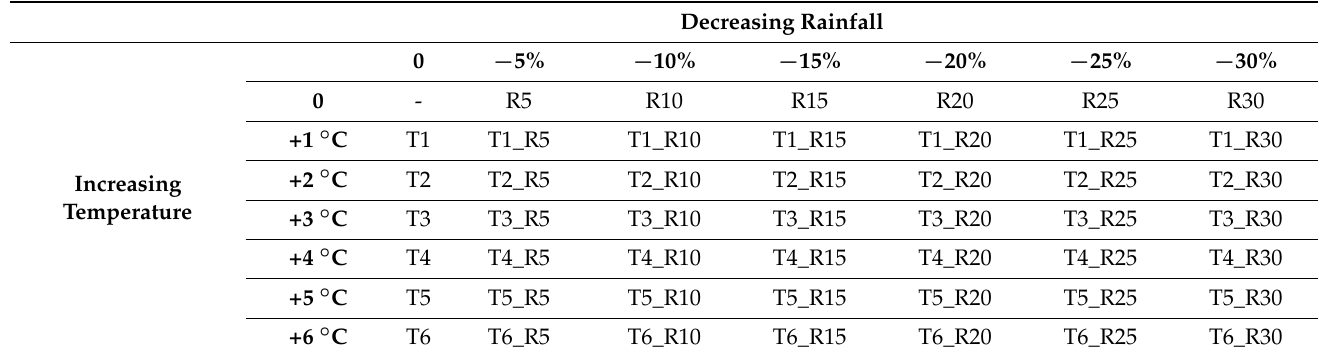
Table 3. Simulated climate change scenarios. R = rainfall; T = temperature. Decreasing